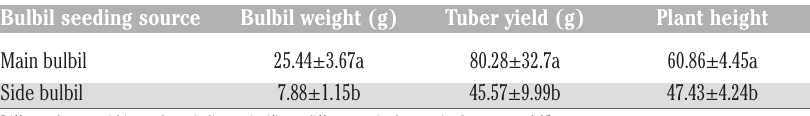
Table 1. Tuber yield and plant height as a factor of seeding source.